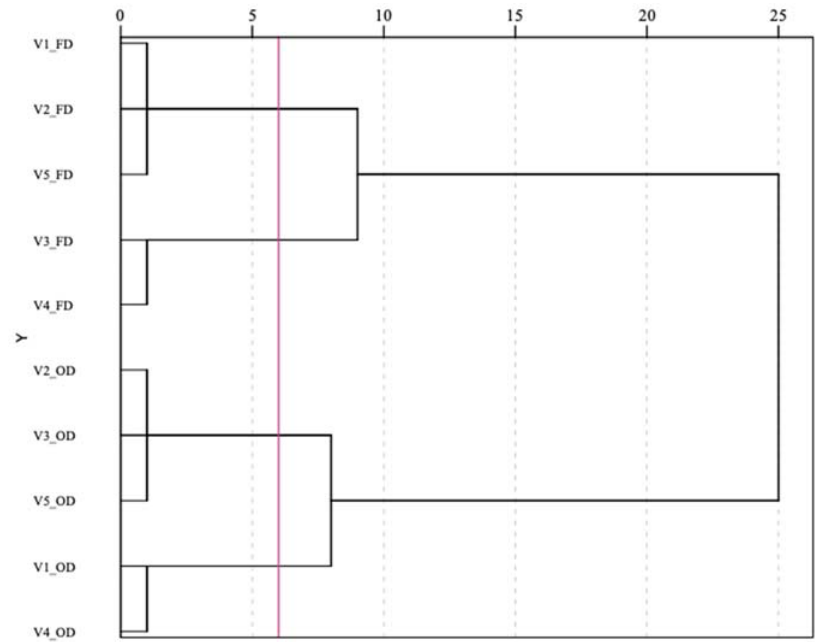
Figure 5. Hierarchical cluster analysis for the Humulus lupulus leaf extracts analyzed. OD—oven-dried samples; FD—freeze-dried samples. V1—Chinook hop leaves; V2—Centennial hop leaves; V3—Comet hop leaves; V4—Columbus hop leaves; V5—Cascade hop leaves. Table 4. ANOVA results of hierarchical cluster analysis (mean SD).